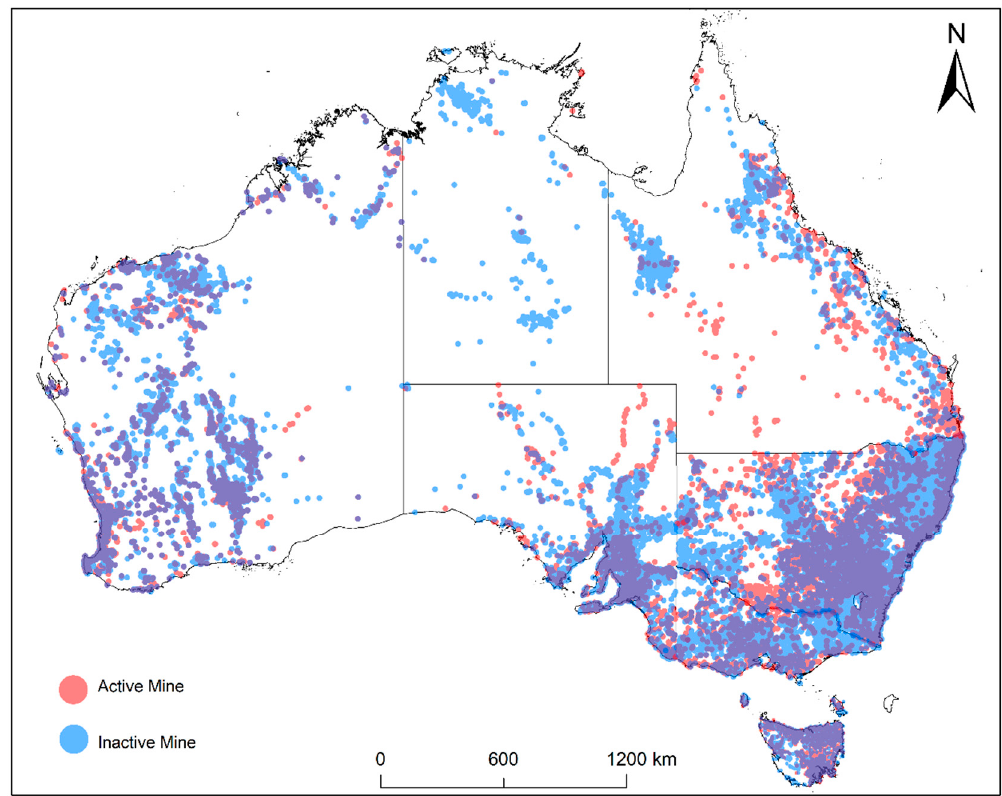
Figure 3. National overview of active and inactive mines across Australia, as identified within our database.